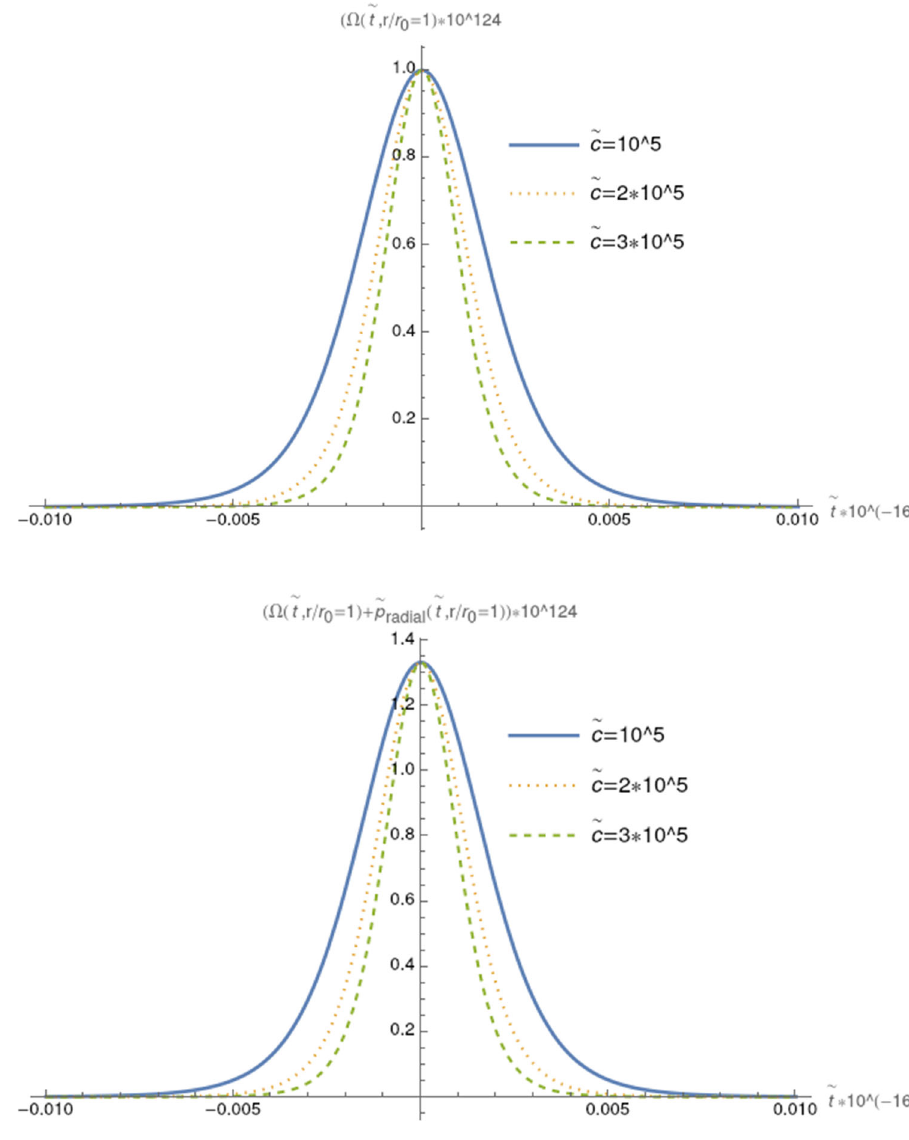
Fig. 1 Here we present the density parameter, (cid:9) divided by factor 10 124 , at the throat, r = r 0 = 10 − 2 / H 0 , for different values of the parameter ˜ c . We also assumed (cid:7)( r , t ) = 0, / r 2 , b ( r ) = r 3 0 S ( t ) = S ( t ) bounce , a min = 10 − 32 and the cosmological parameters (cid:9) 0 = 0 . 692, (cid:9) 0 = 0 . 308 v ac mat